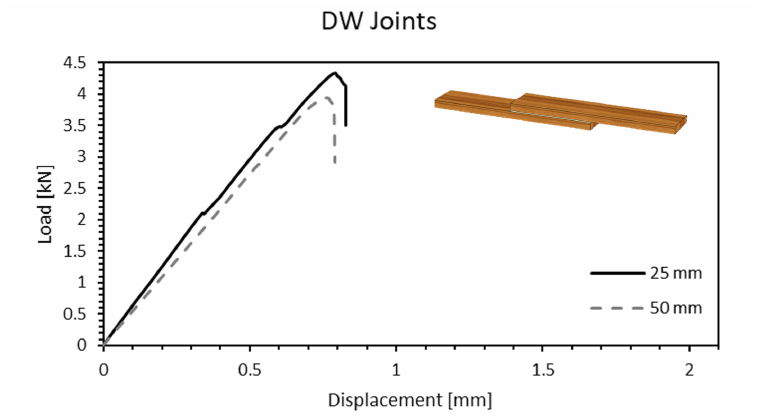
Figure 11. Load-displacement curve of a DW joint for 25- and 50-mm overlap